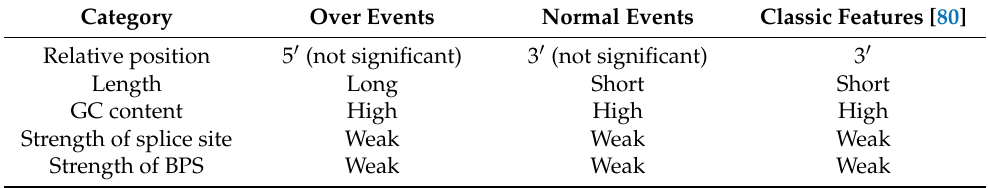
Table 3. Characteristics of alternative introns in RI (compared with constitutive introns). Category Over Events Normal Events Classic Features [80] Relative position 5 (cid:48) (not